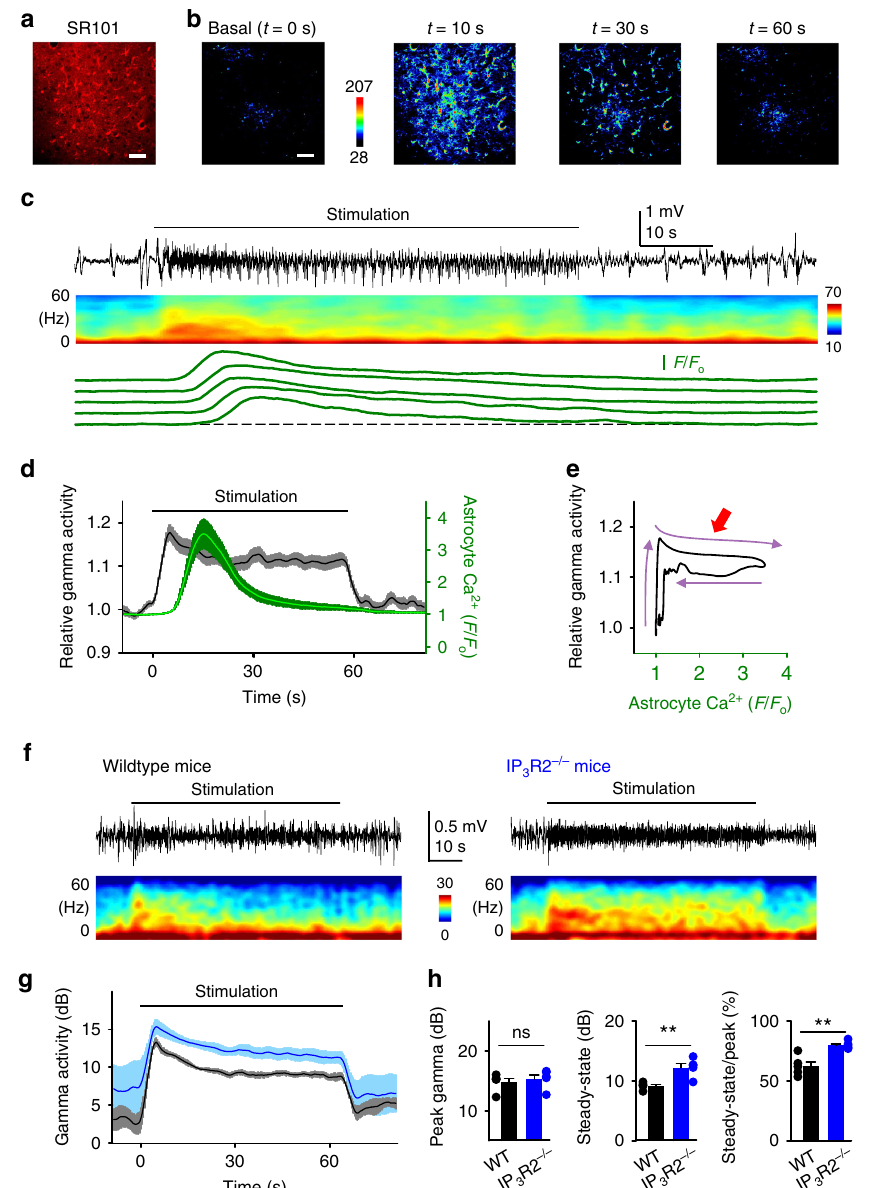
Fig. 4 Astrocyte – neuron interactions revealed during sustained sensory stimulation. a SR101 staining. Scale bar = 50 µ m. b Representative pseudocolor Ca 2 + images of basal astrocyte activity and during hind paw stimulation at indicated times from the stimulus onset. Scale bar = 50 µ m. c ECoG recording (black top trace), spectrogram (middle), and astrocyte Ca 2 + levels (green bottom traces). d Relative gamma activity (black) and relative astrocyte Ca 2 + levels (green) over time; horizontal black bar indicates sensory stimulation (2 mA, 5 Hz, 60 s). Lines and shadows represent mean and SEM, respectively, as in other panels. e Relative gamma activity vs. astrocyte Ca 2 + levels. Note the hysteresis loop between neuronal network activity and astrocyte calcium denoted by purple arrows, and the gamma activity decrease following the increase in astrocyte Ca 2 + levels (red arrow). f Extracellular recordings (black top traces) and spectrograms (bottom) from wildtype (left) and IP 3 R2 − / − (right) mice. g Gamma activity vs. time from wildtype (black) and IP 3 R2 − / − (blue) mice in response to sustained sensory stimulation. h Peak gamma response to stimulation (left; p = 0.59; n = 5 animals each), steady-state gamma activity after 50 s of the stimulation (center; p = 0.003) and the ratio of steady-state over peak gamma (right; p = 0.002). Mean± SEM. ns: p > 0.05 and **: p < 0.01 using two-sided student t -test. Images and traces are representative of data obtained independently across 5 mice. Source data are provided as a Source Data fi